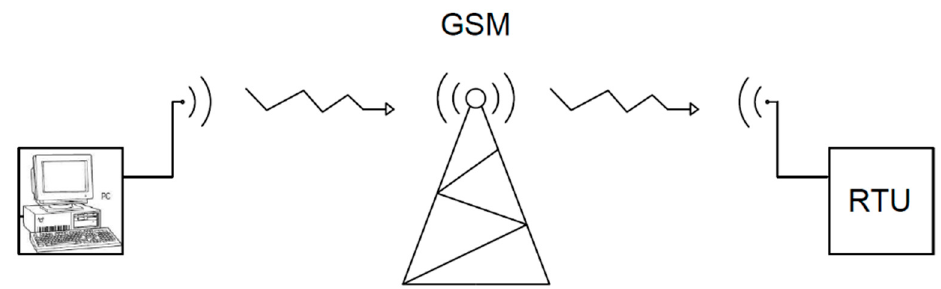
Figure 8. Block diagram of the GSM-based control system of the railway station. GSM = global system for mobiles; RTU = remote terminal unit.